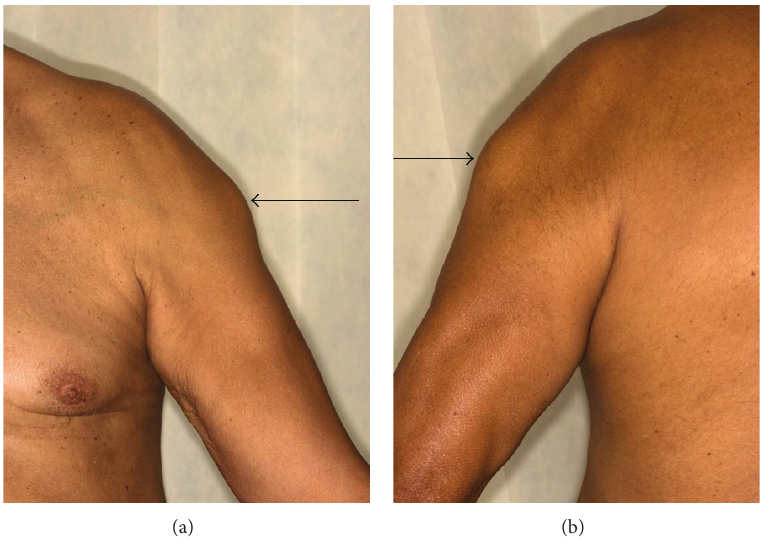
Figure 1: Clinically, the lesion was a relatively well defined, firm approximately 7 cm mass over the left biceps muscle, fixed to the underlying structures. No erythema of the overlying skin is seen in this example (case 2).